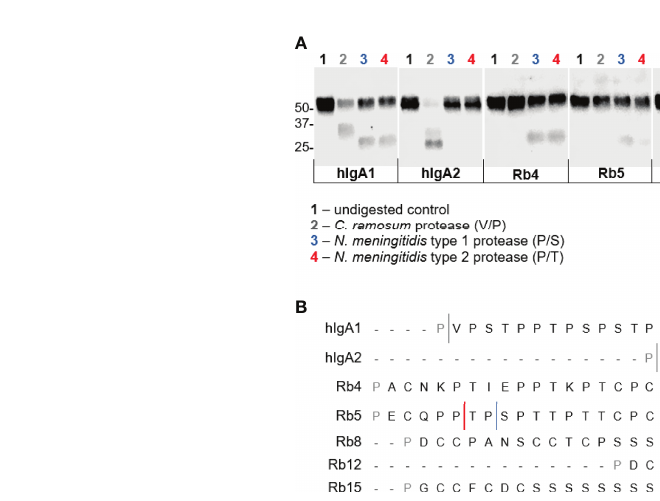
FIGURE 6 | Action of IgA proteases derived from Clostridium ramosum and Neisseria meningitidis on hIgA1, IgA2m (1) and rabbit hinge hybrids. (A) Western blot analysis of proteins separated under reducing conditions and probed with anti-human IgA-peroxidase conjugate. Positions of molecular mass markers are shown in kilodaltons on the left. (B) Representation of the amino acid sequence of the human IgA1 and IgA2m (1) hinge region and the cleavage sites of different bacterial IgA proteases. Rabbit C a 4, C a 5, C a 8 (or C a 13), C a 12 and C a 15 hinge regions are also represented, and putative cleavage sites are